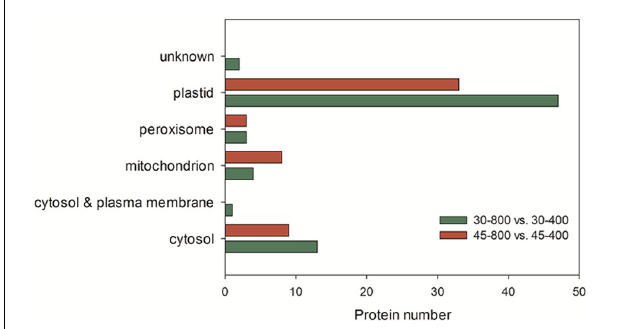
FIGURE 10 | Subcellular location of identified proteins in response to different CO 2 concentrations and temperatures. The treatments symbols are 30 and 45 for normal temperature control and heat stress and 400 and 800 for ambient CO 2 and elevated CO 2 concentrations,